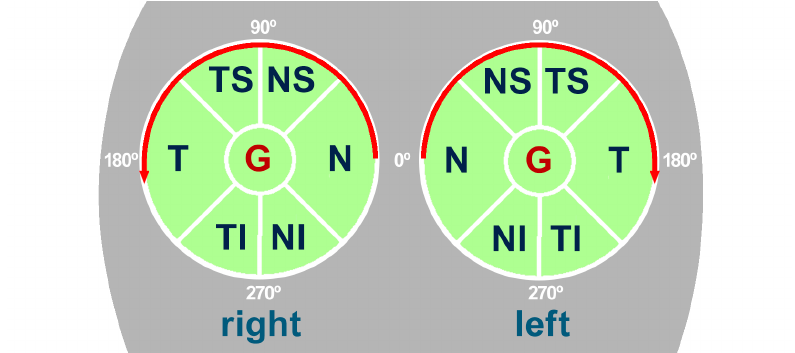
Figure 2. Diagram of the situation of the sectors of the eye in relation to the face of the subject. Table 1. Relations between the polar and Cartesian coordinates in the OCT projection.